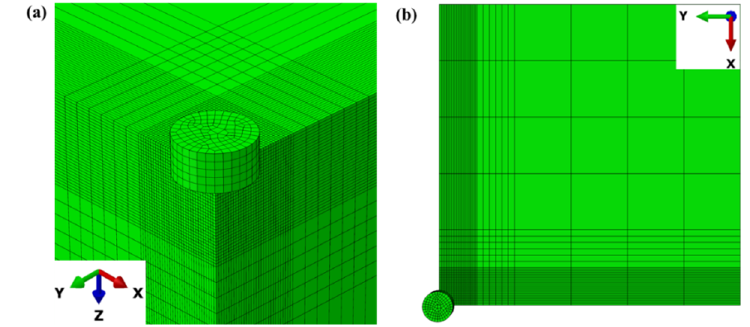
Figure 5. Meshing elements of the rock: ( a ) Part view. ( b ) Top view.